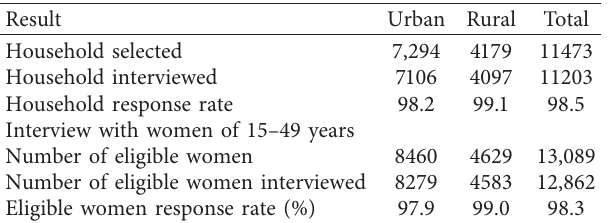
Table 1: Distribution of sampled household and participating women in NDHS 2016